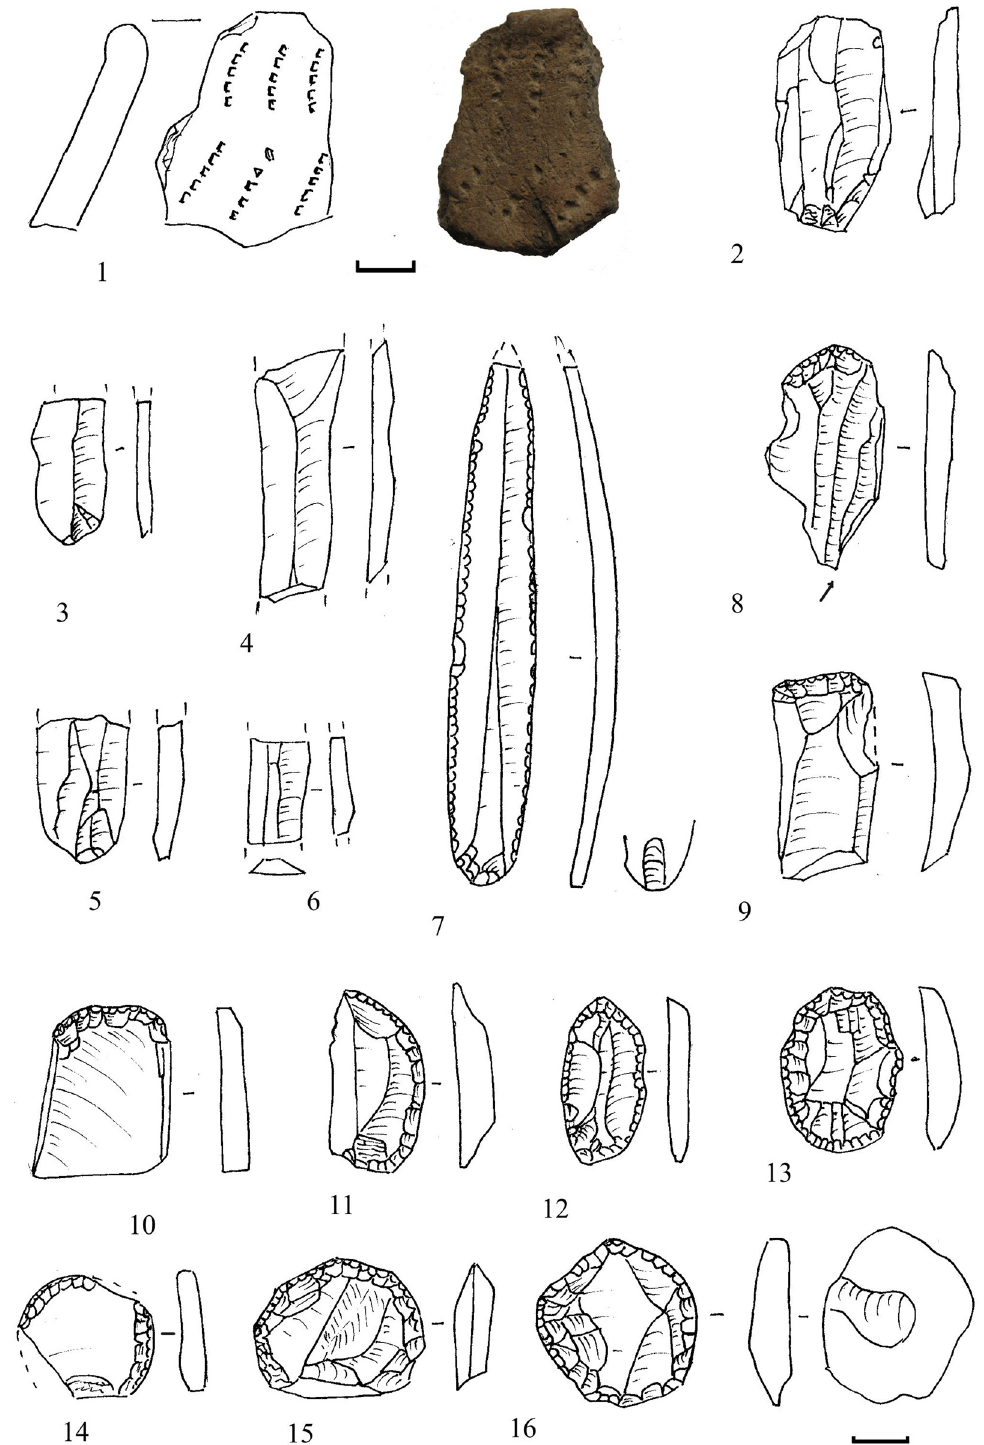
Figure 6: Finds from Razdolnoe ( middle seventh millennium BCE ) . 1 – a shard with comb decoration; 2 – 4, 5 – 6 – laminar products; 7 – blade with convergent retouch; 8 – 16 – end -